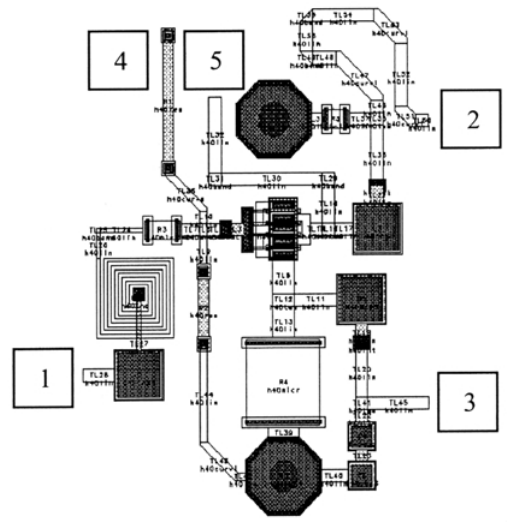
FIGURE 27 Final layout of the active